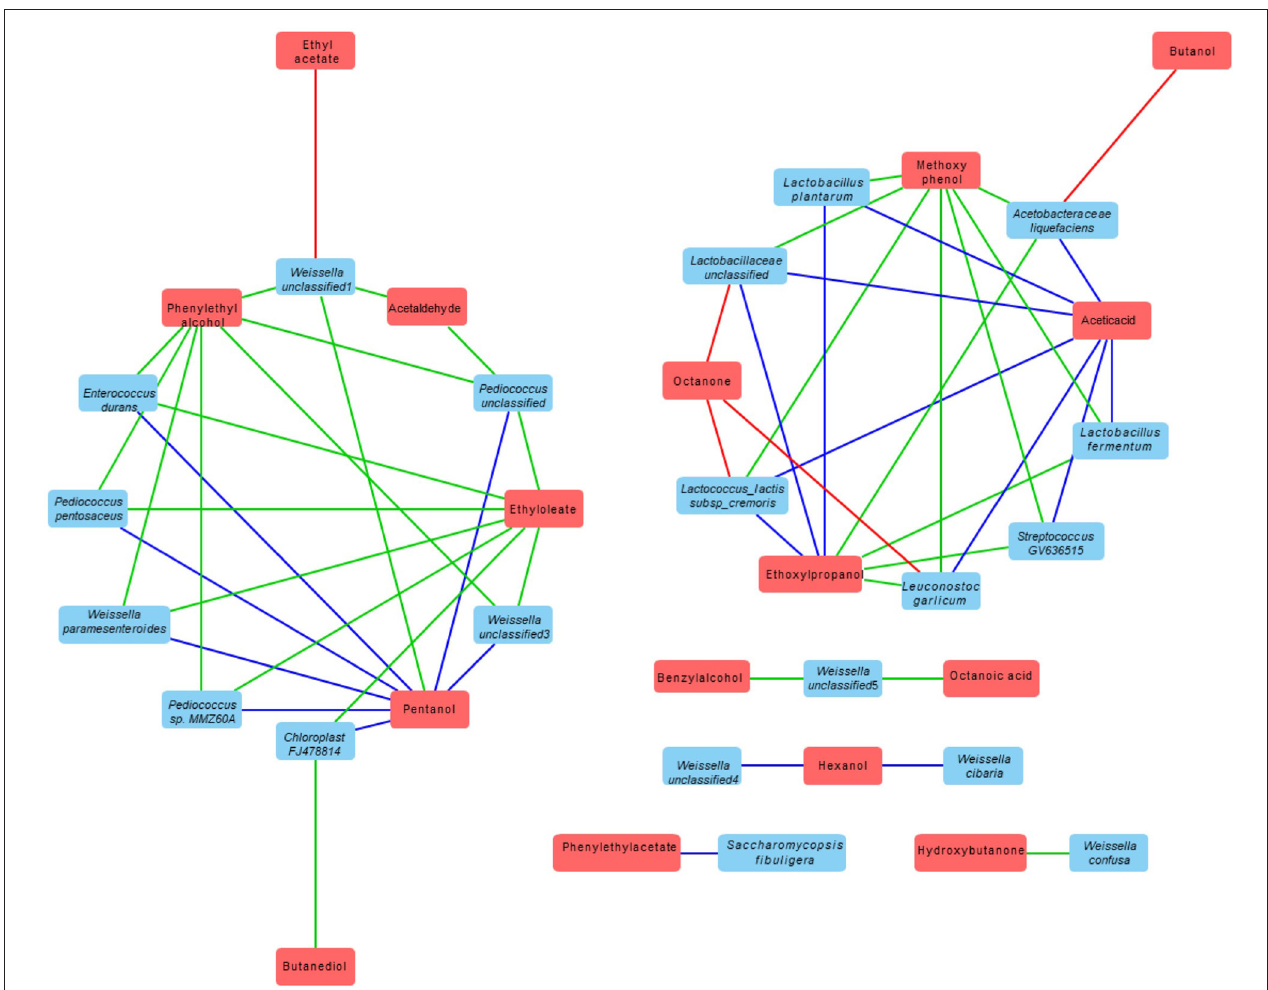
FIGURE 6 | Correlation network between volatile metabolites and microbial starters (based on Cytoscape software). The red boxes represent volatile metabolites and blue boxes correspond to microbial strains that are correlated with this metabolite. The blue line represents the positive correlation with a level of significance of 0.01, the green line represents the positive correlation with a level of significance of 0.05 and the red line represents the negative correlation with a level of significance of